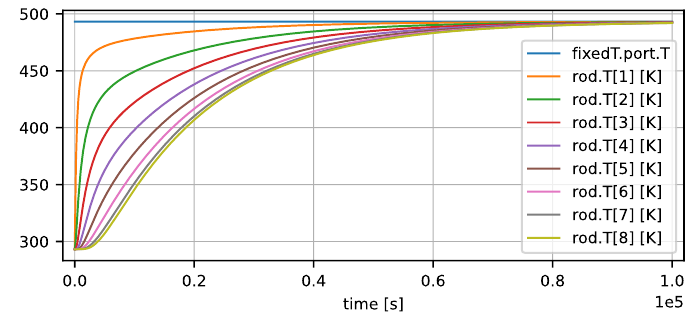
Figure A2. Plot of temperatures of heated rod model of Listing